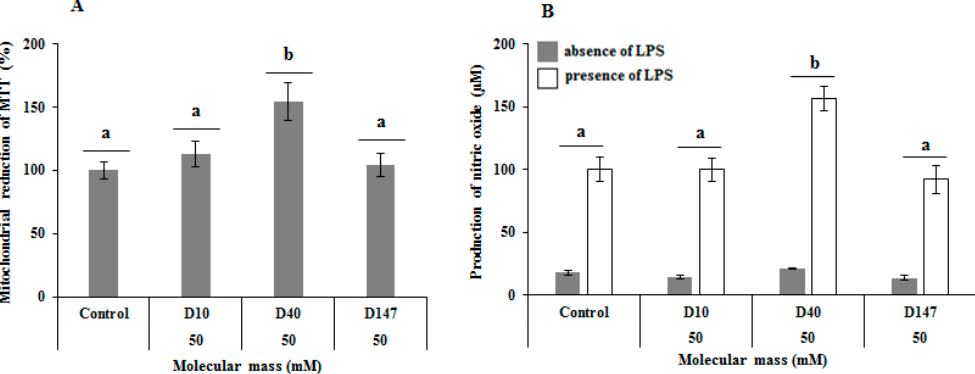
Figure 3. Effect of D10, D40 and D147 in RAW cells: ( A ) 3-(4,5-dimethylthiazol-2-yl)-2,5- diphenyltetrazolium (MTT) mitochondrial reduction by cells in the presence of glucans; and ( B ) nitric oxide production by RAW cells in the presence of glucans. Letters a,b represent the significant difference between the various samples according to the simple variation analyses (one-way ANOVA) followed by the Tukey–Kramer ( p < 0.05) test. LPS, lipopolysaccharides.